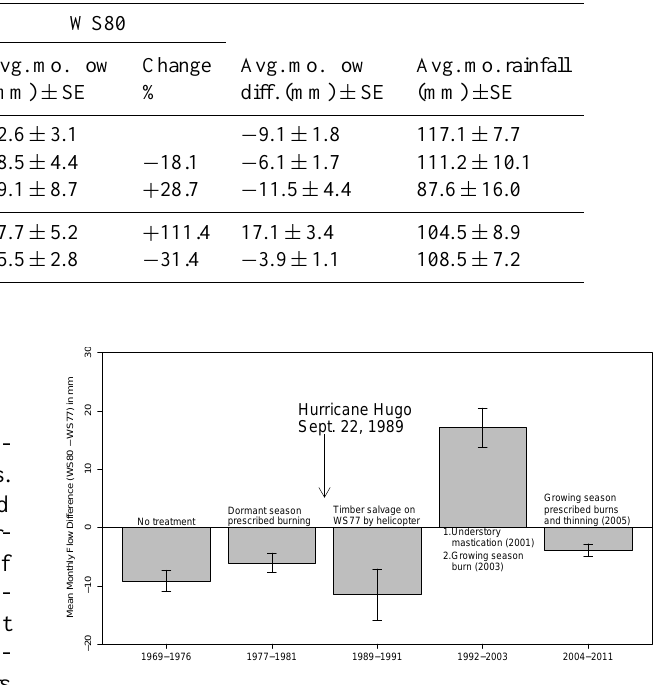
Fig. 6. Mean monthly flow differences between WS77 and WS80 from 1969–2011. No records were collected from 1982 to Sept. 1989. Listed treatments were applied only in WS77.